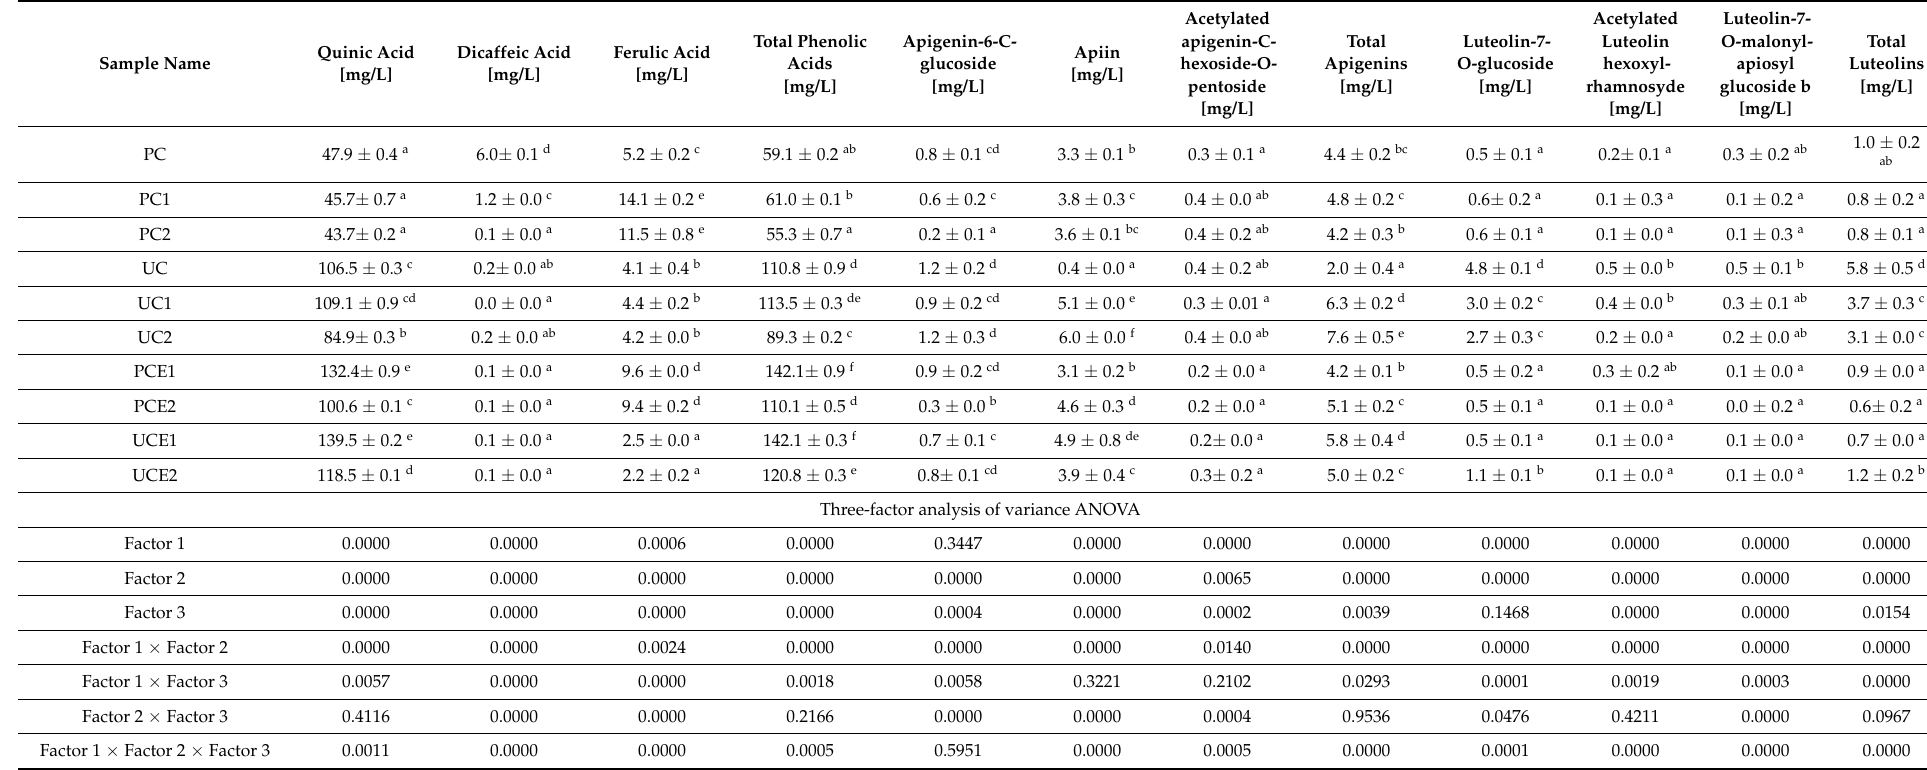
Table 4. Effect of pectinase on celeriac pulp on the content of selected phenolic acids, apigenins, and luteolins in